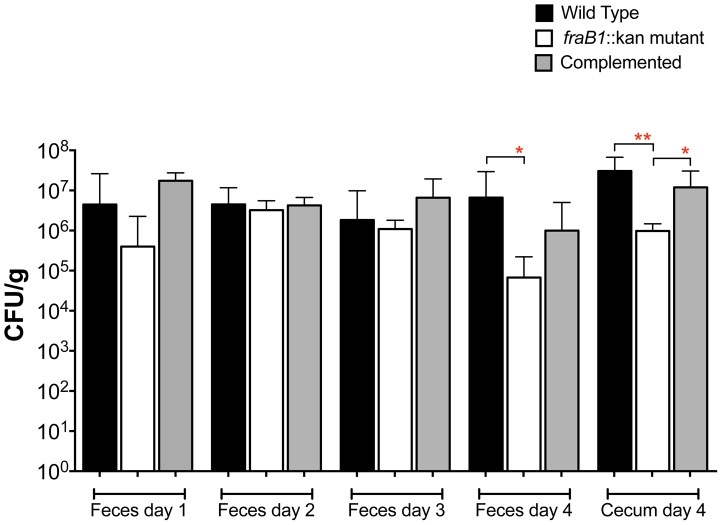
Quantitation of Salmonella in feces on days 1 through 4, and cecum on day 4, post-infection.Groups of five C57BL/6 mice heterozygous for Nramp1 were orally inoculated with 107 CFU of IR715 (wild-type), MA59 (fraB1::kan mutant), or ASD6000 (fraB1::kan mutant with complementation plasmid pASD5006). The geometric mean+SE is shown. Statistical significance between select groups was determined by using an unpaired two-tailed Student t test. * = P value<0.05, ** = P value<0.01.